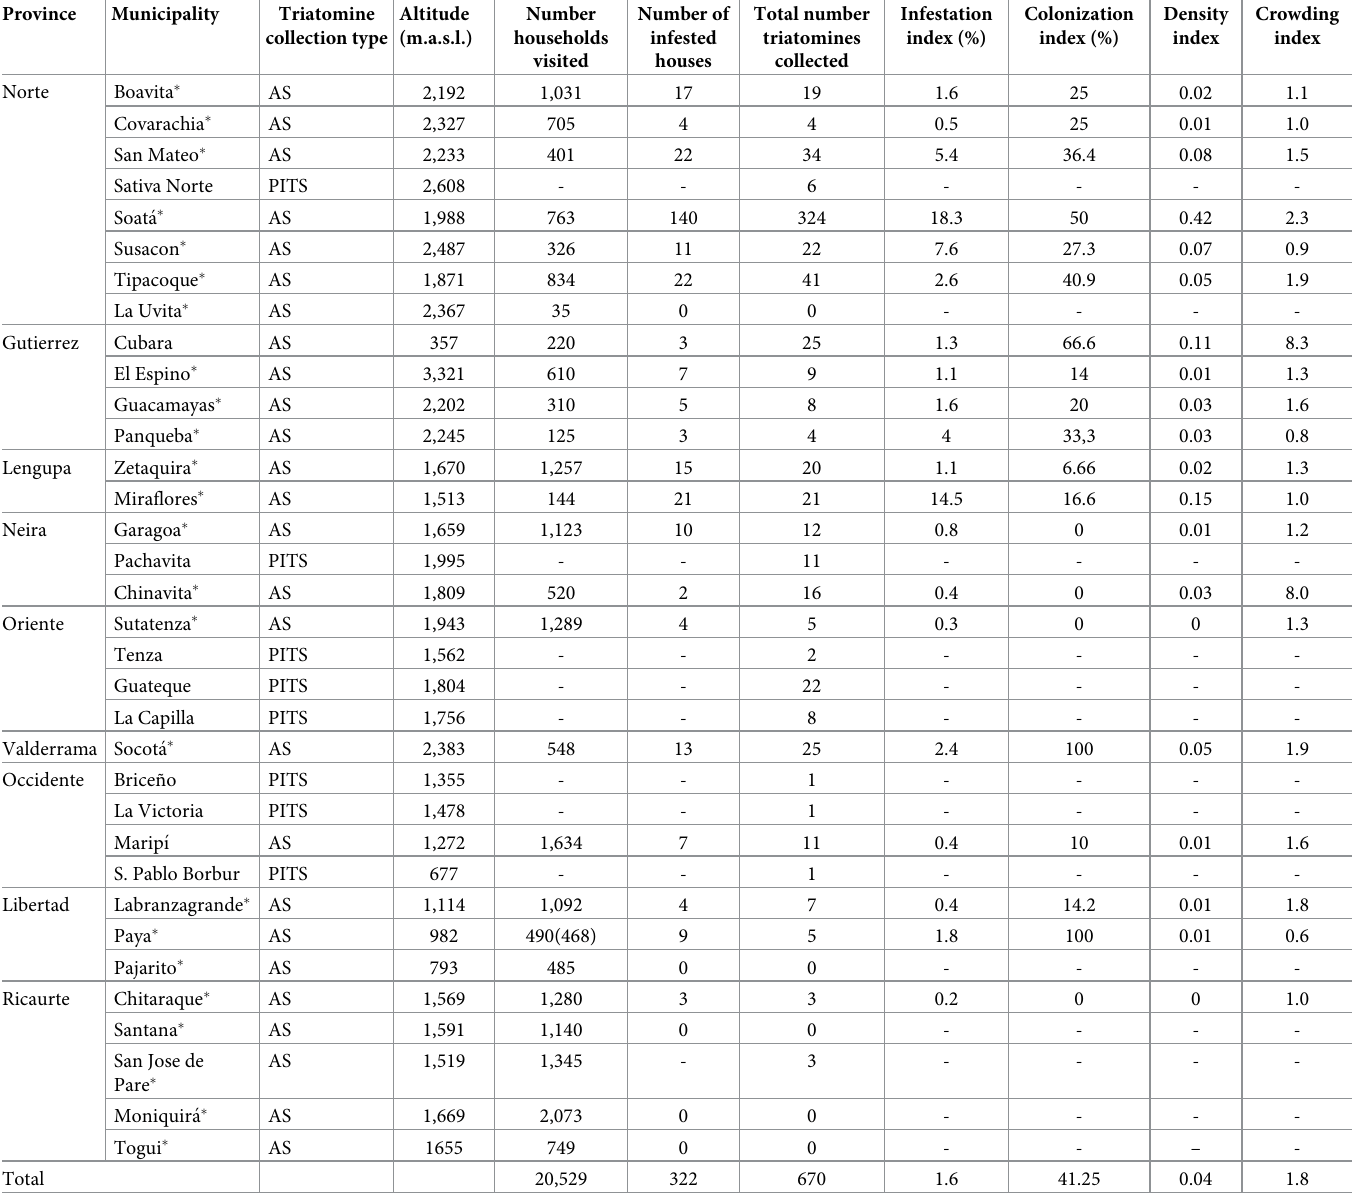
Table 1. Entomological indexes in municipalities from Boyaca, from March 2017 to November